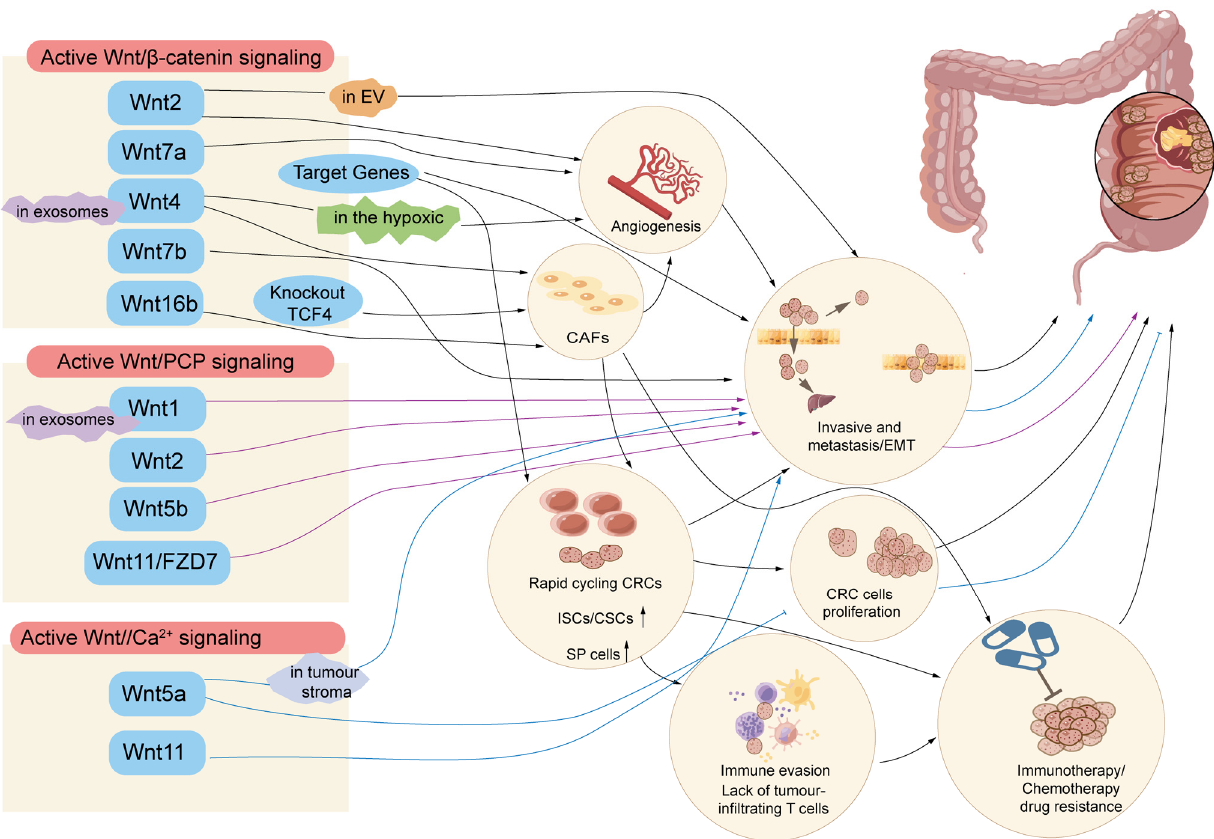
Figure 3. The Wnt signalling pathway in the biochemical process of colorectal cancer (CRC). The aberrant Wnt pathway drives the cancer stem cells, the tumour microenvironment, angiogenesis, invasion, metastasis, and drug resistance in CRC.